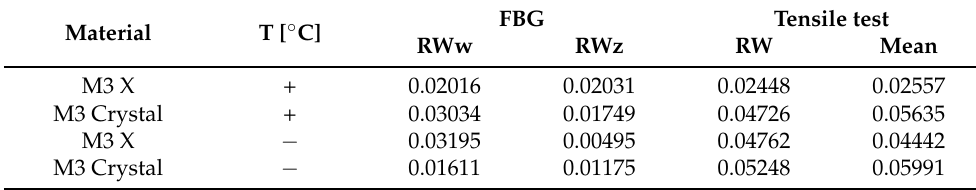
Table 12. Comparison of the maximal strain (m/m) in the tensile